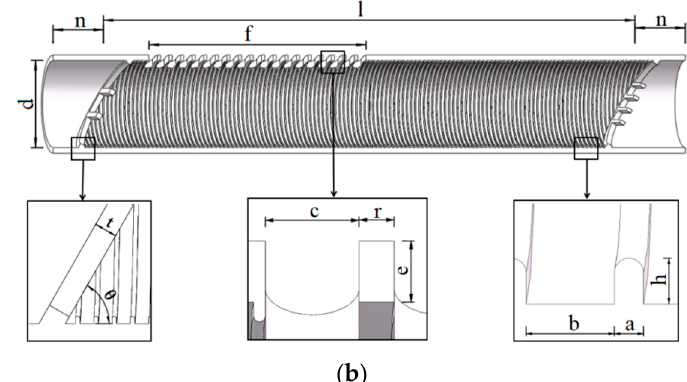
Figure 3. Schematic diagram of the vessel structure and model: ( a ) vessel structure; ( b ) fluid-domain model of the vessel. Table 1. Geometry parameters of Magnolia